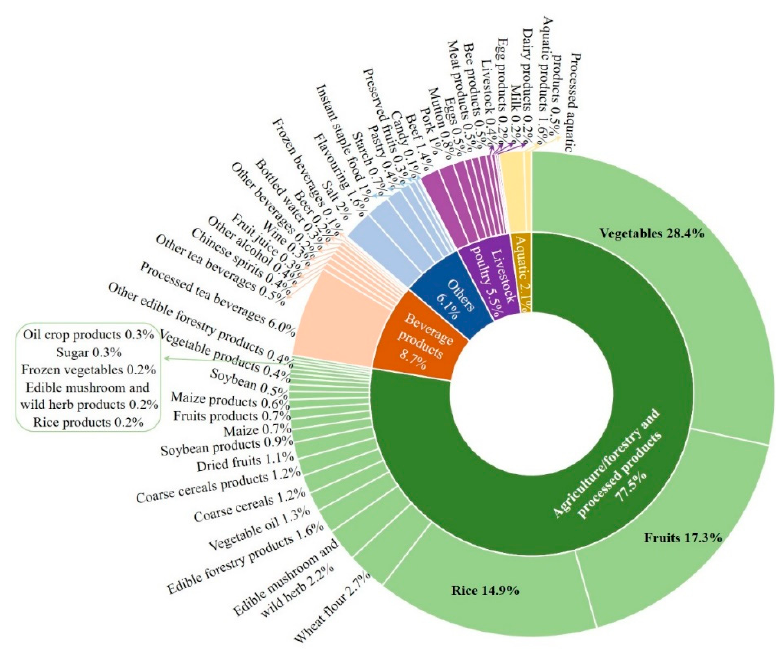
Figure 5. Green food categories and their corresponding proportions on the basis of the amount of product in China.